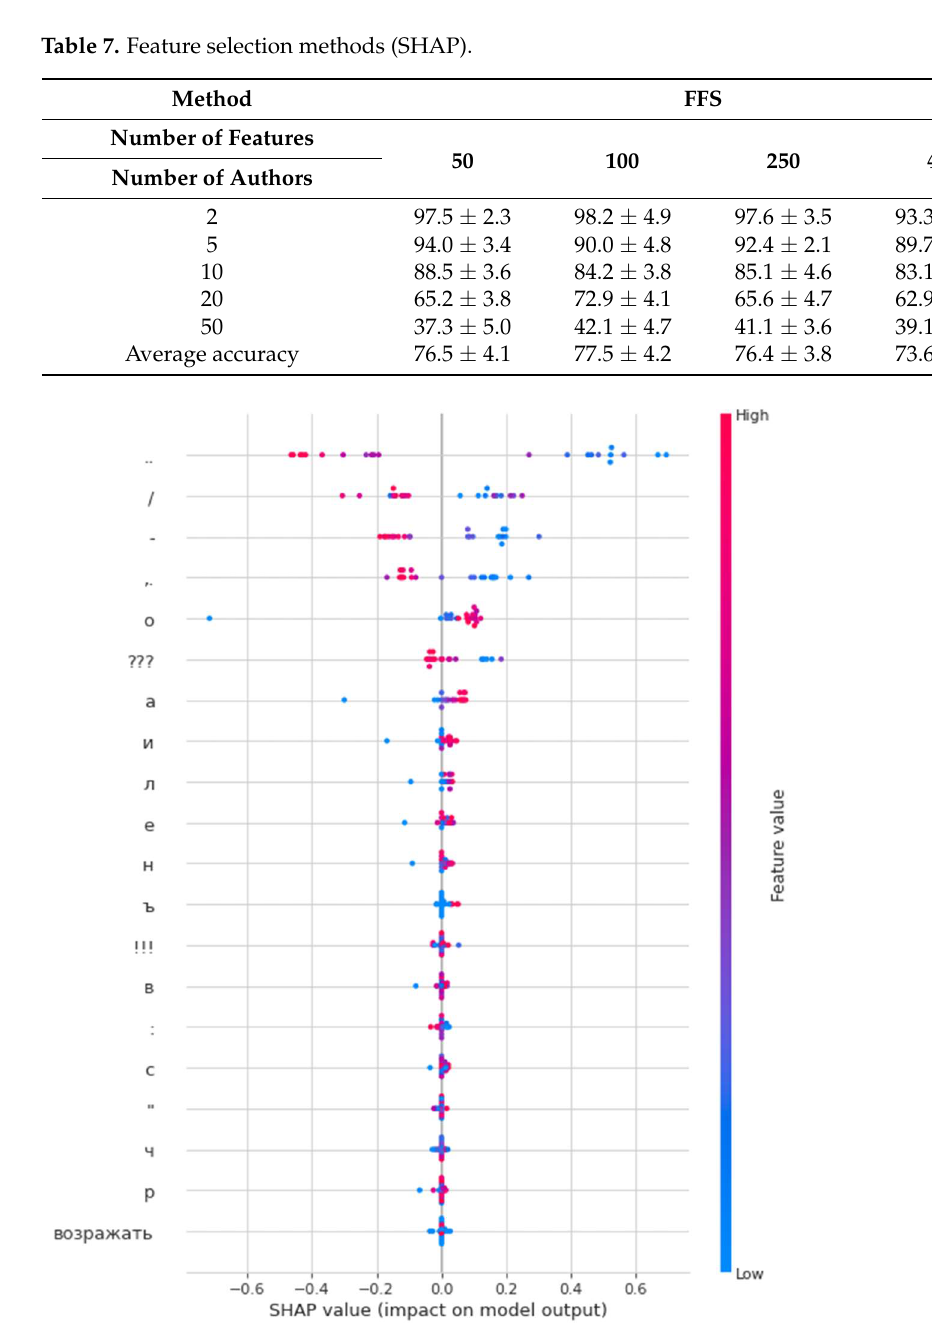
Figure 7. SHAP informative